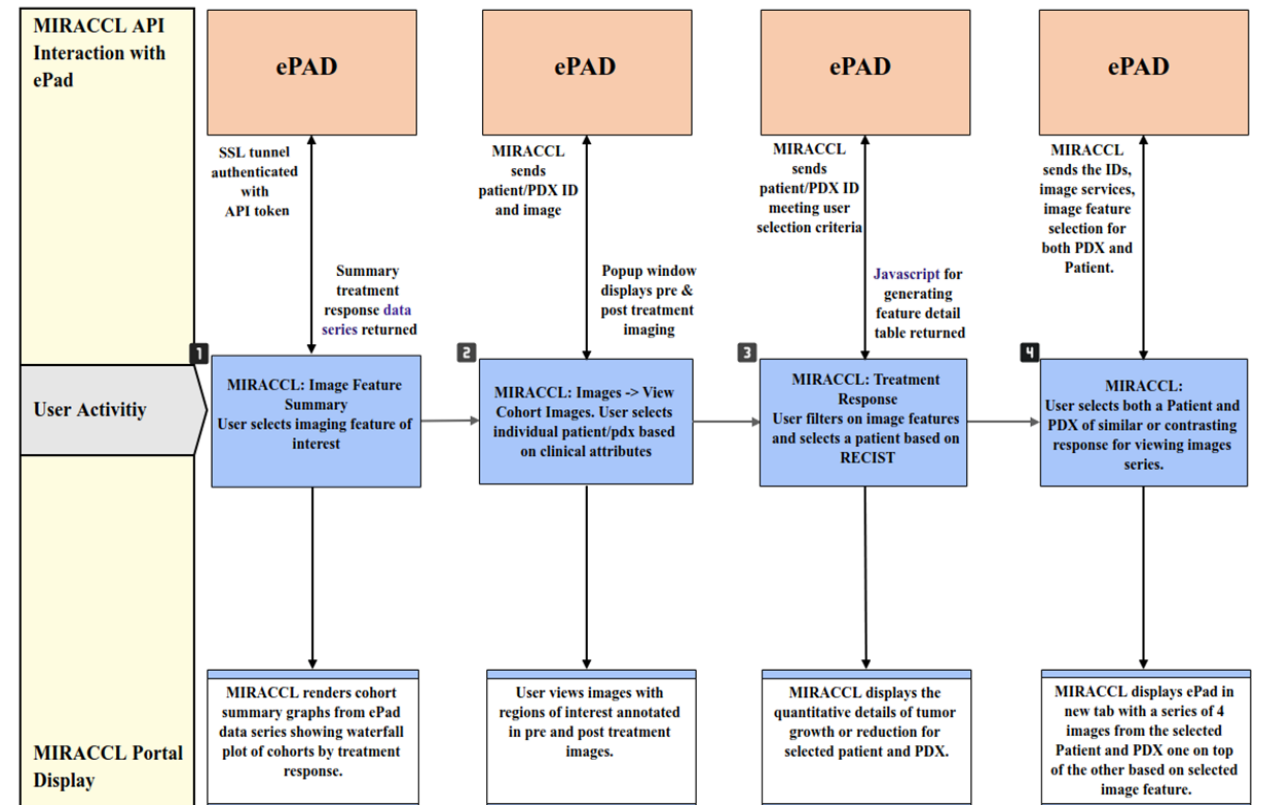
Figure 4. Interactions between ePAD and MIRACCL. User activity within MIRACCL in steps one through four. Imaging data analysis API requests from MIRACCL to ePAD are shown on the top row while resulting MIRACCL user interface (UI) responses are shown on the bottom row.